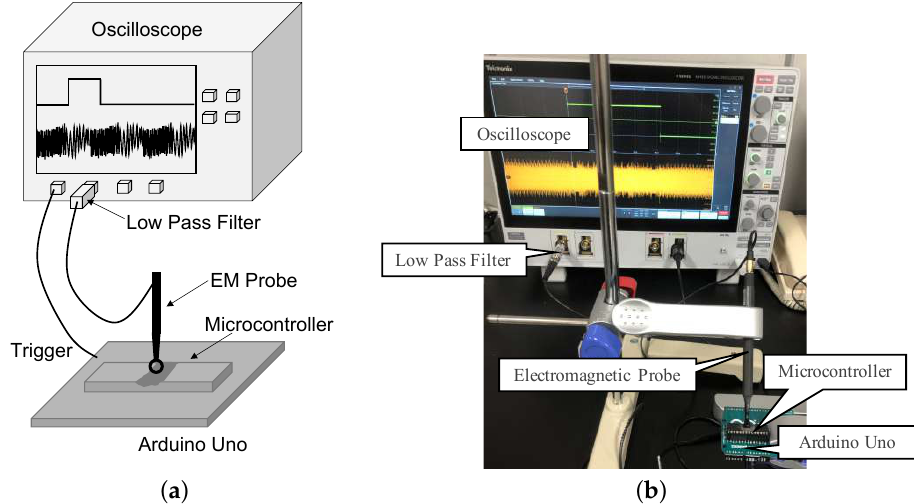
Figure 3. Experimental Setup. ( a ) Measurement Setup Model. ( b ) Full Measurement